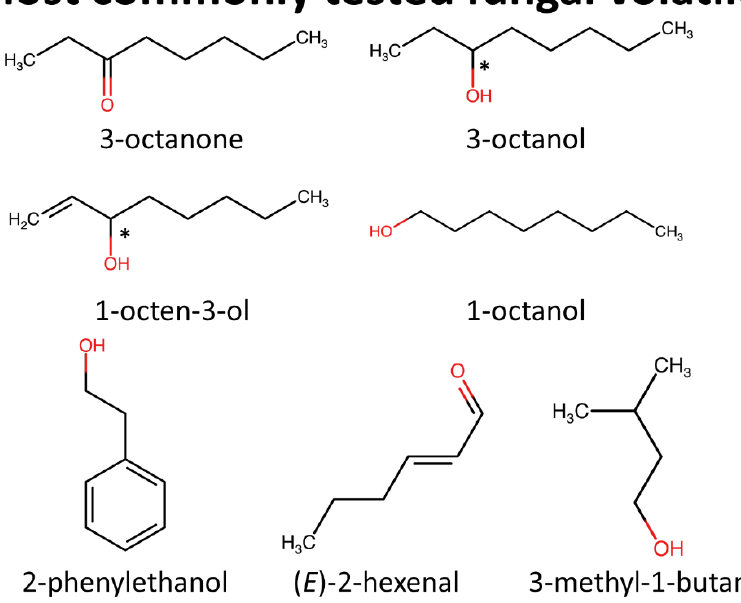
Figure 2. Chemical structures of the most commonly tested MVOCs against stored-product arthro- pods, which collectively represent 60% of the n = 185 tests of individual components in the literature. Functional groups are highlighted in red, while asterisks indicate chiral centers.